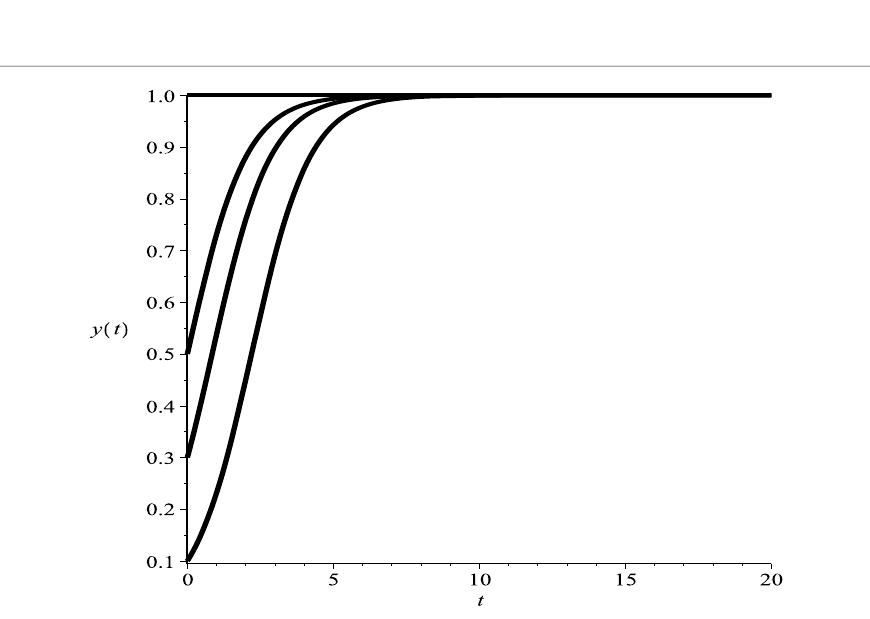
structured commensalism model. This motivated us to propose system (1.1), which is the most simple commensalism system with stage